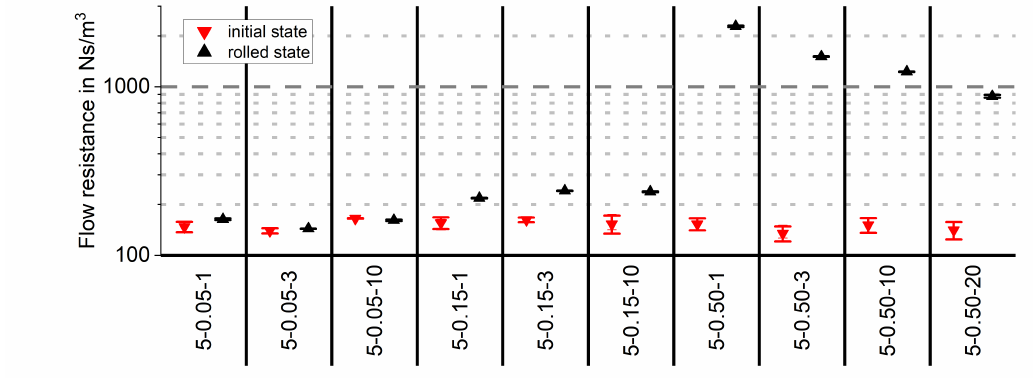
Figure 18. Flow resistance (mean value with standard deviation) for samples with 5mm initial